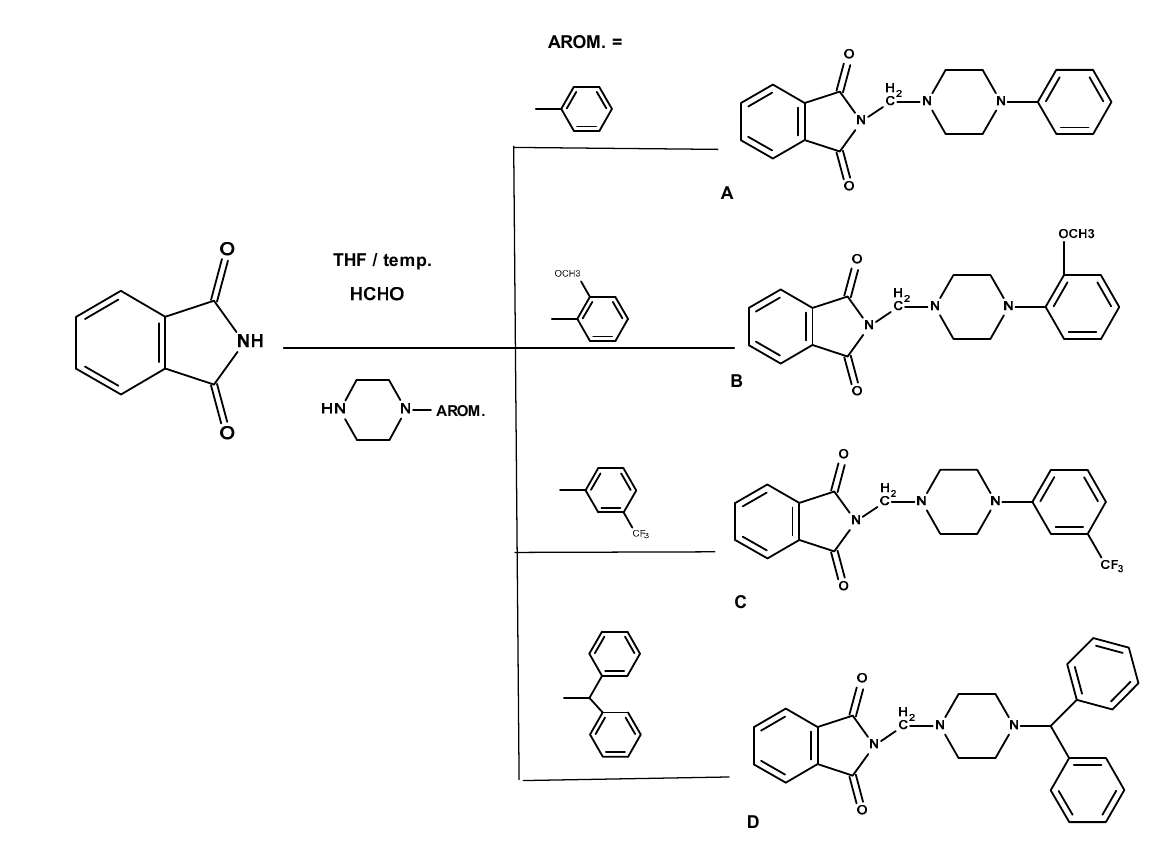
Scheme 1. Synthetic scheme of the studied compounds A – D.